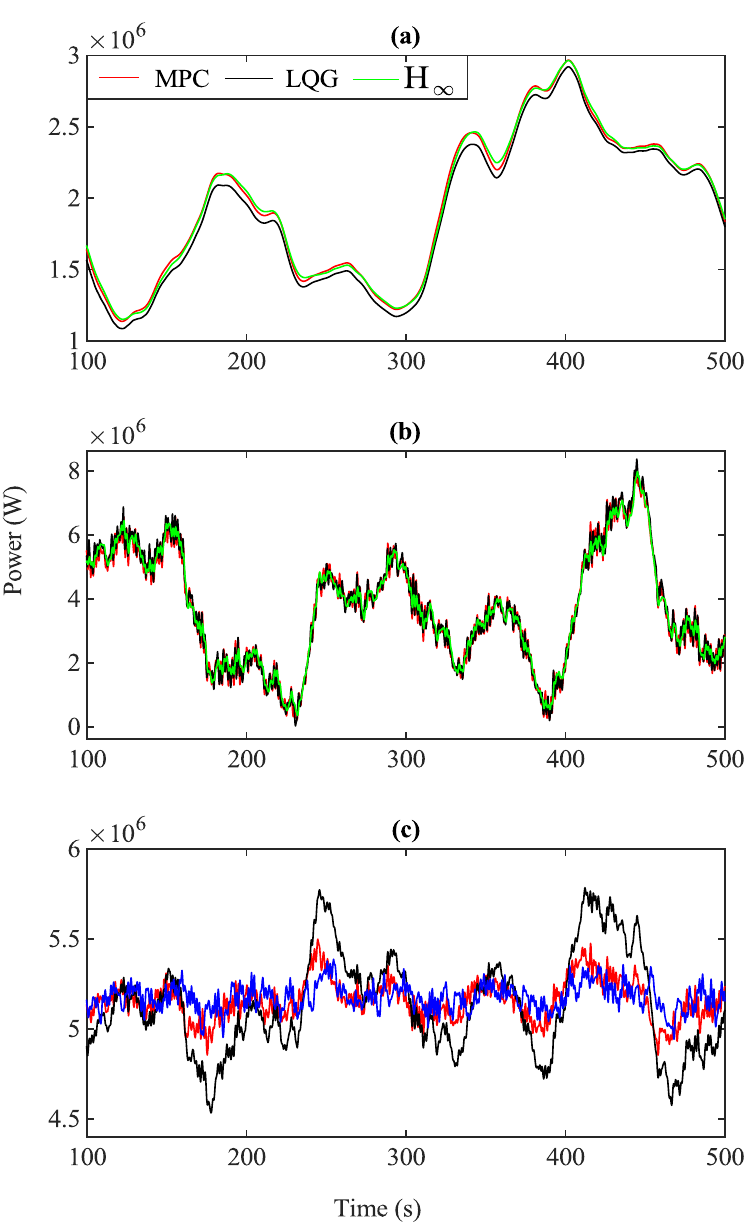
Figure 11. Time responses of power in modes 1, 2, and 3: MPC, LQG, and H ∞ based on Bladed linearization model; ( a ) mode 1, ( b ) mode 2, ( c ) mode